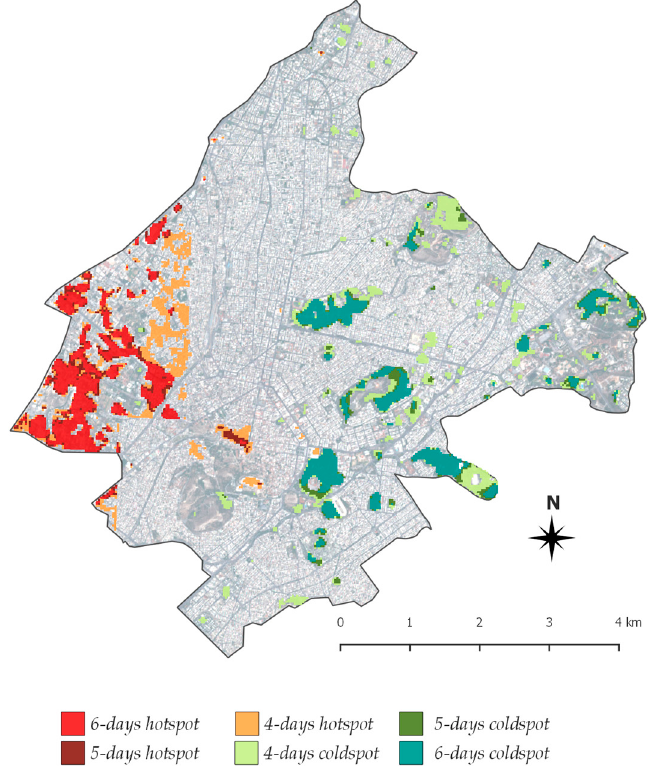
Figure 5. Location of the hot/cold spots within Athens Municipality. (A: old industrial area of Athens, B: the historic center of Athens).